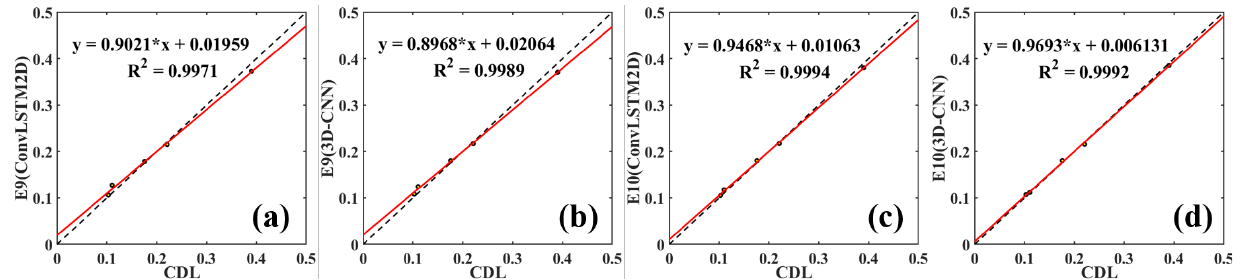
Figure 10. Correlation of crop-area ratio. (( a – d ) correspond to four experiments, as shown in the vertical label. The scatter points mean the fraction of different crop over the study area. The red line reflects the consistency of crop area between the classification results and the CDL.)